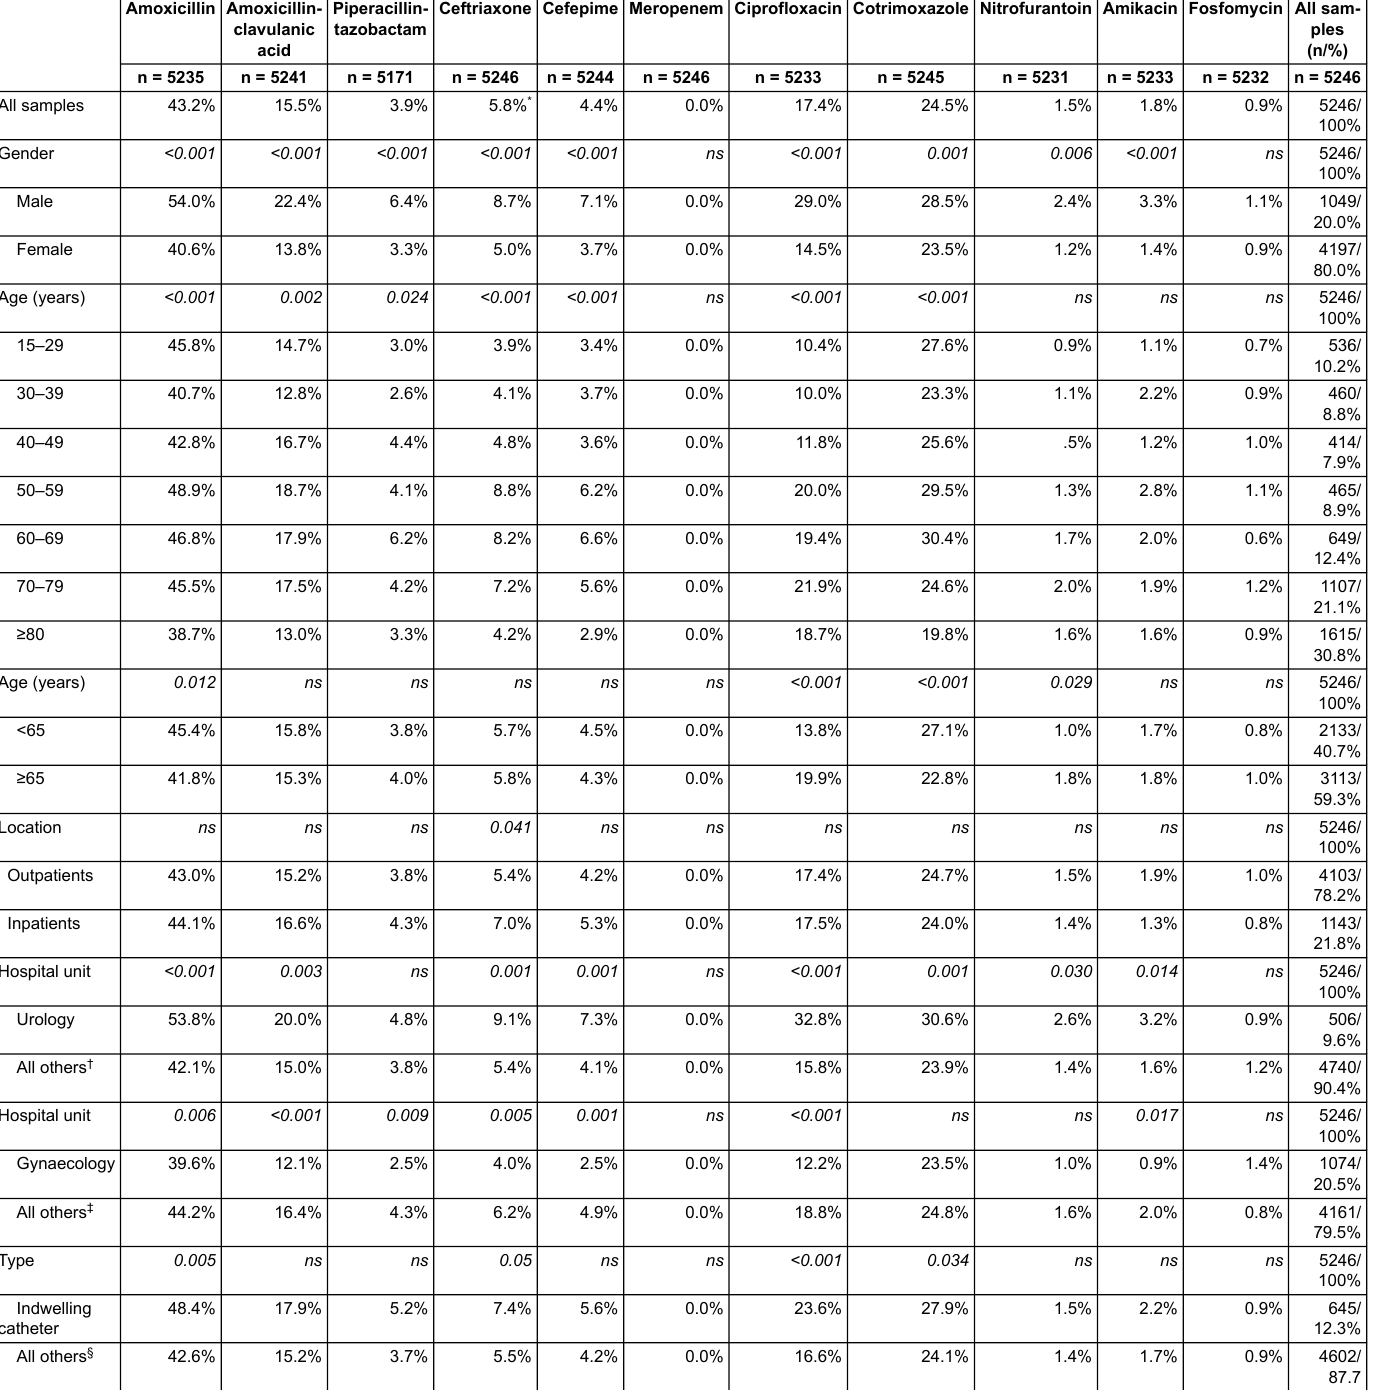
Table 2: Percentage of E. coli resistant to different antibiotics cummulative and stratified by gender, age, location, hospital unit, type of urine specimen and quantification. Amoxicillin Amoxicillin-